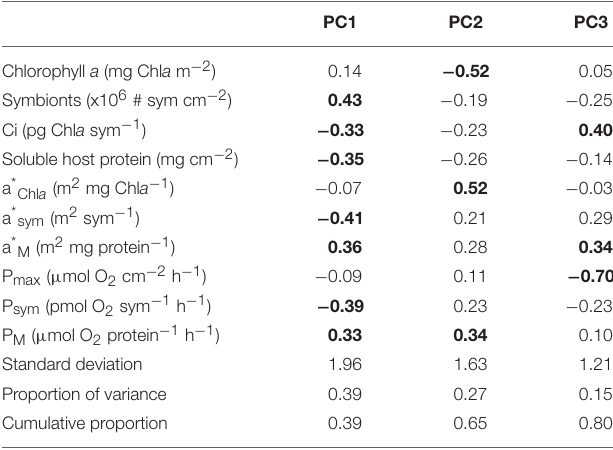
TABLE 2 | PCA analysis for the structural, optical, and photo-physiological coral descriptors of the un-stressed samples of Orbicella annularis, O. faveolata , Montastraea cavernosa, and Pseudodiploria strigosa .